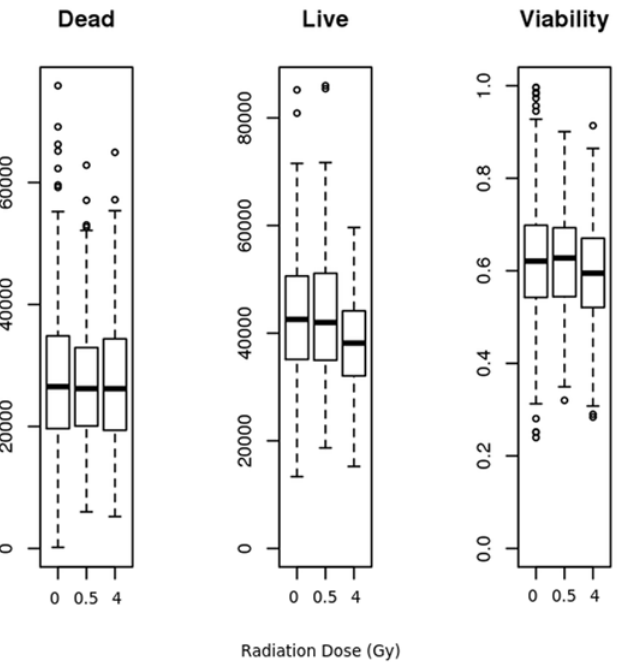
Fig 1. Cytotoxicity assay performance. Estimate of Dead cell relative light units (RLU), Live cell RLU, and % Viability for all clones at 0-Gy, 0.5-Gy and 4-Gy irradiation. While dead cell RLUs do not show statistically significant changes, changes in live cell RLUs and % Viability at 4-Gy are statistically significant indicating that as a whole, clones show fewer live cells and decreased viability at 4-Gy, presumably due to cell cycle arrest and decreased cell